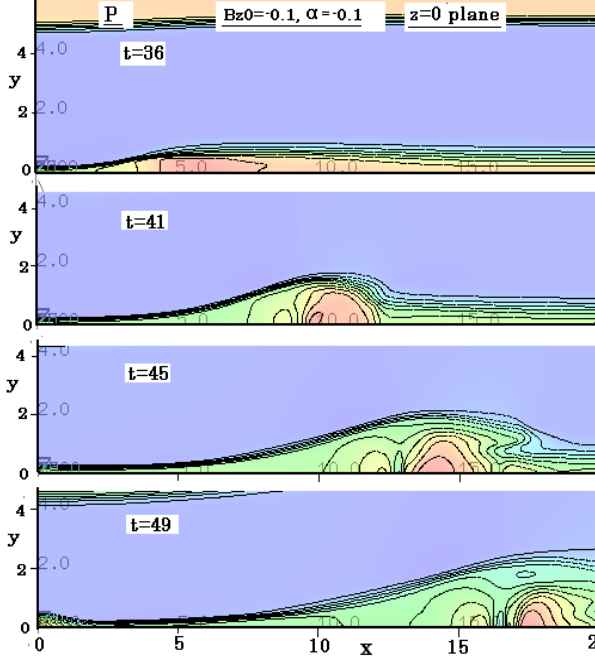
Figure 3: Proflles of ·J z along the x axis for the case of B z 0 = 0 : 1 and fi = 0 : 1 at difierent times. ¡ ¡